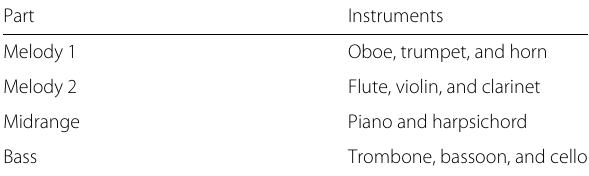
Table 2 Musical instruments used in the music dataset Part